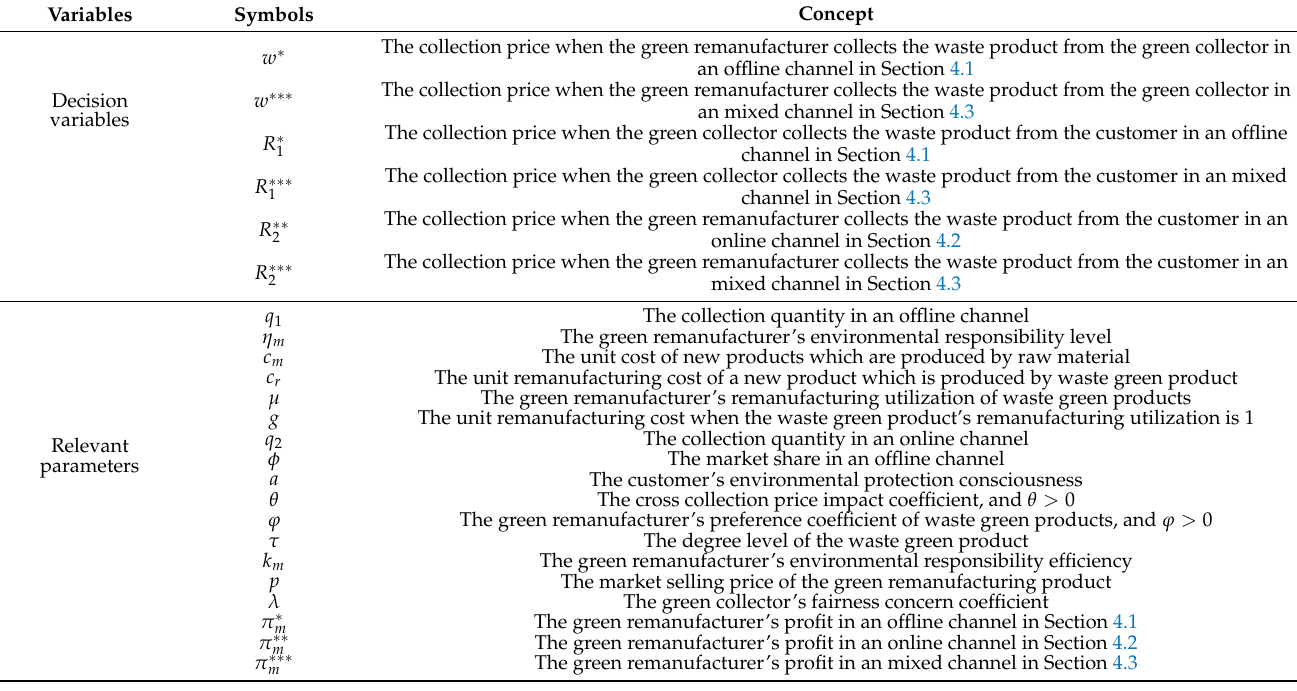
Figure 1. Three collection channels of the green remanufacturer’s. Table 1. The relevant parameters and decision